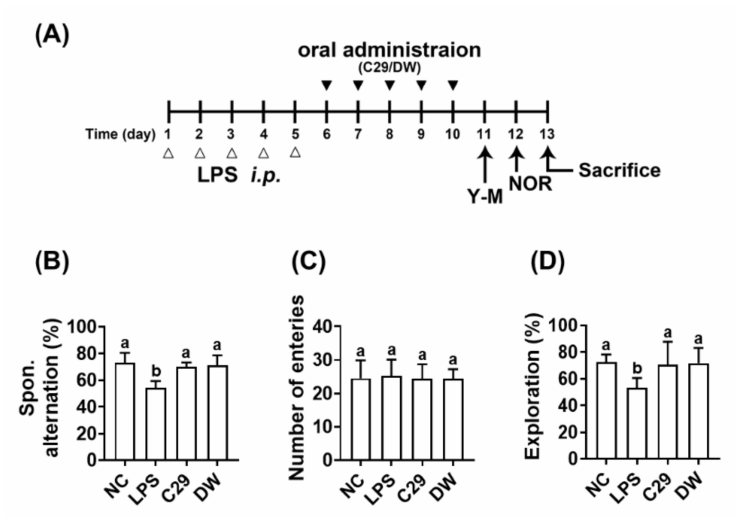
Figure 1. C29 and DW2009 alleviated LPS-induced cognitive impairment in mice. ( A ) Experimental schedule. ( B ) Effects on spontaneous alternation in the Y-maze task. ( C ) Effects on the number of the arm entries in the Y-maze task. ( D ) Effects on exploration in the novel object recognition task. NC was treated with saline instead of LPS (white triange). Test agents (black triangle: LPS, vehicle alone; C29, 1 × 10 9 CFU/mouse/day of C29; DW, 100 mg/kg/day of DW2009) were orally gavaged in mice daily for 5 days after the intraperitoneal injection of LPS. Thereafter, behavioral tasks in the Y-maze (Y-M) and novel object recognition apparatus (NOR) were performed. Data values are as mean ± SD ( n = 7). Means with same letters are not significantly different ( p <